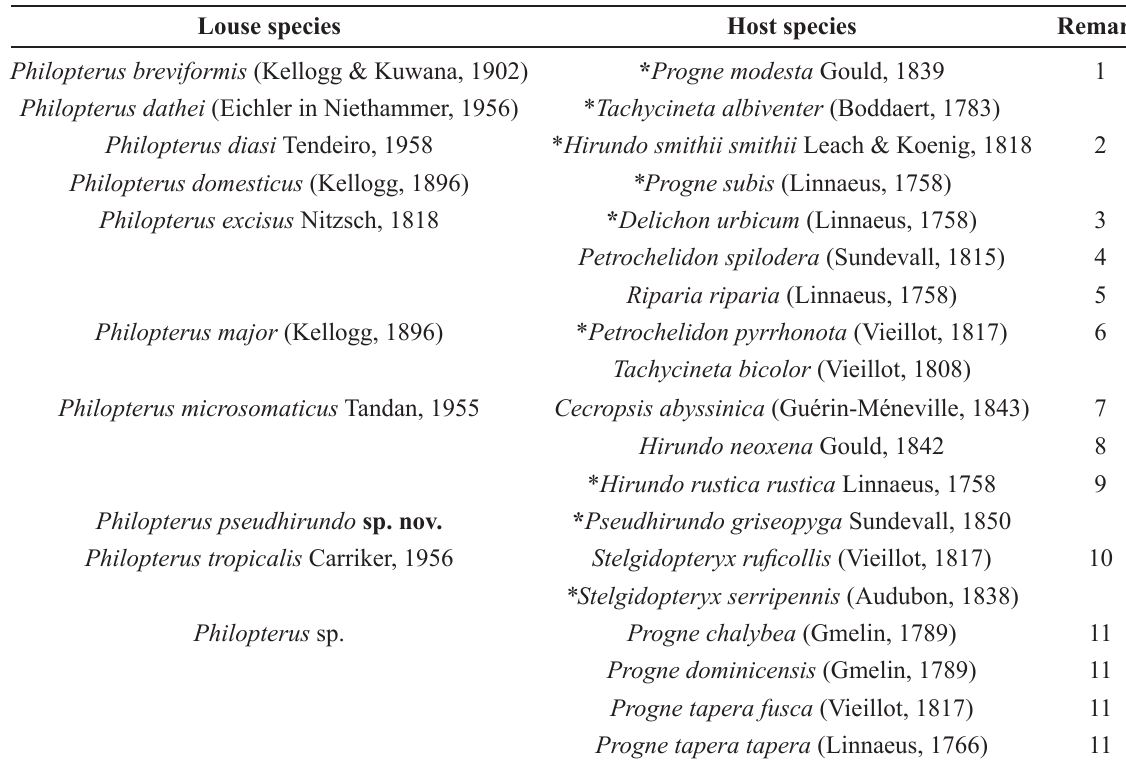
Table 7. Checklist of the known distribution of species of the genus Philopterus Nitzsch, 1818 on swallows (Hirundinidae). Type host species are indicated by an asterisk